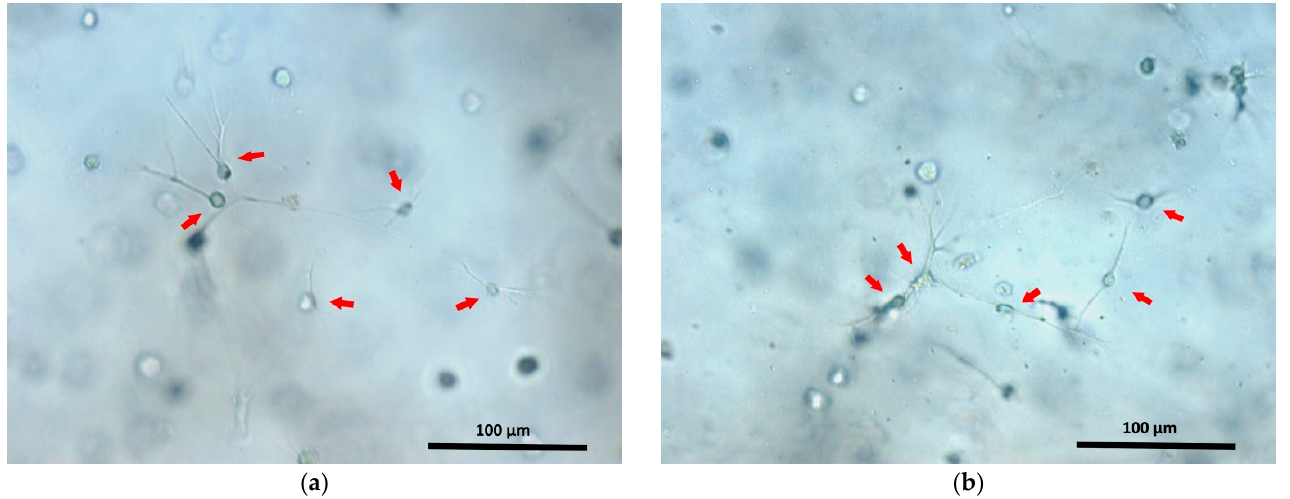
Figure 8. ASCs cultivated for 24 h in fish ( a ) and bovine ( b ) collagen scaffolds. The arrows indicate some of the ASCs. Cellular processes are well visualized in adhered ASCs.